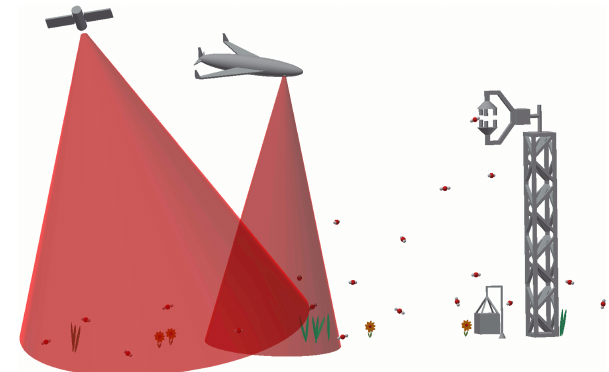
Figure 1. Current state-of-the-art approaches for greenhouse gas monitoring to a large extend rely on deploying bulky and expensive laboratory devices in the field. In order to cover large areas remote sensing is currently the only viable option albeit at poor temporal